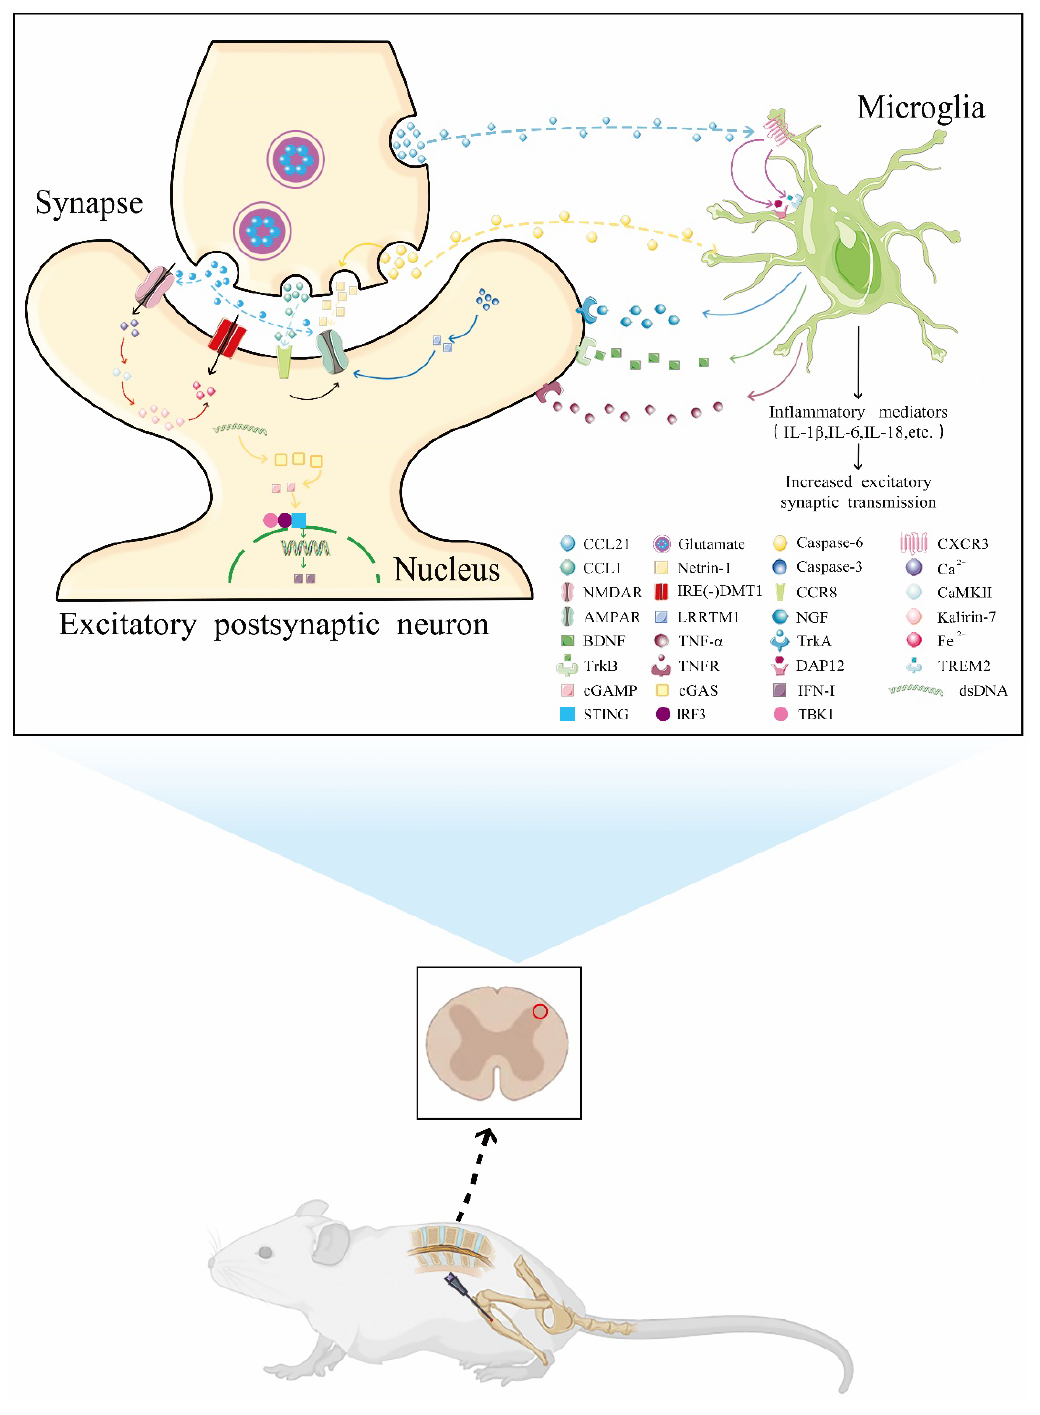
Figure 1. Recent insights into the molecular mechanisms of chronic pain after fractures and ortho- pedic surgery. Pain injury from fractures and orthopedic surgery causes mechanical deformation of somatosensory nerve endings innervating bone and muscle, and the hyperexcitability of primary sensory neurons triggers the release of multiple cytokines from the presynaptic membrane of primary nociceptive sensory neurons, which are involved in CFP processes. These mainly include: (1) CCL21 released from presynaptic neurons acts on its specific receptor CXCR3 in microglia, which promotes TREM2/DAP12 complex formation and induces microglial activation; (2) the enhanced activity of caspase-6 in the presynaptic membrane can directly act on microglia to accelerate their activation, and it can also promote the release of Netrin-1 and promote the postsynaptic transport of AMPA